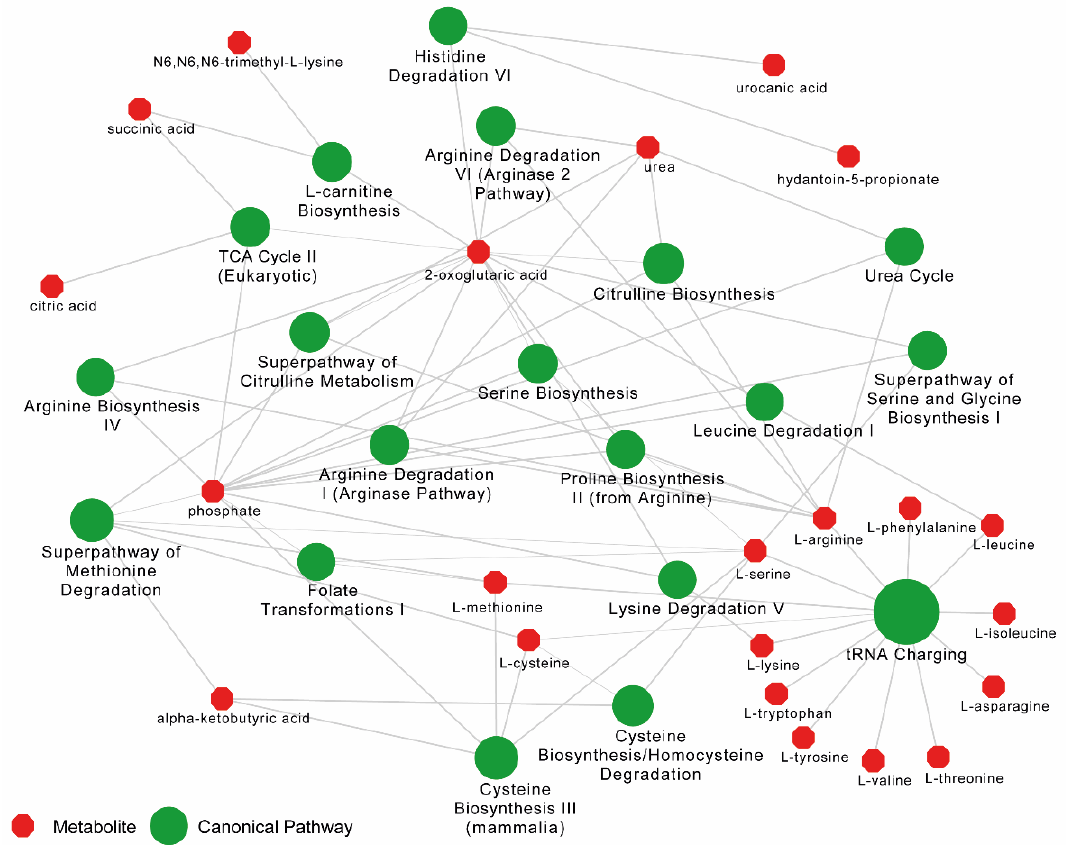
Figure 3. Pathway enrichment analysis results from Ingenuity Pathway Analysis (IPA) for metabolome data between PLHIV and HC. Top 20 canonical pathways (in green) are shown. Bubble sizes are relative to p -values. The metabolites (in red) related to each pathway are linked with a continuous gray line.